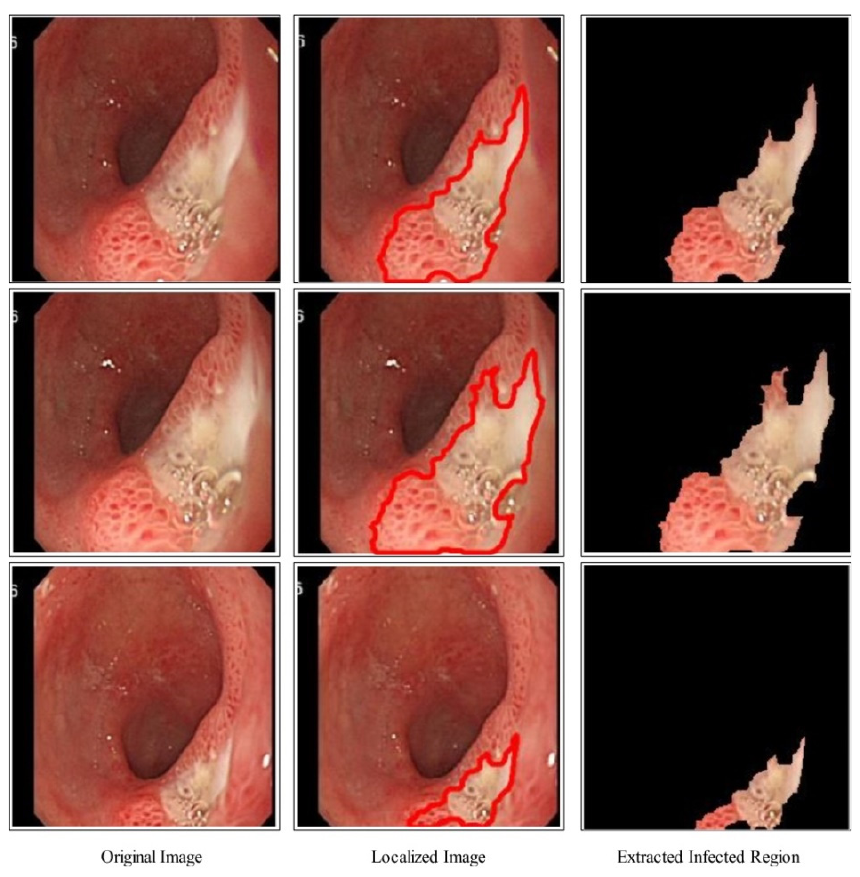
Figure 5. Proposed ulcer localization using deep saliency map.